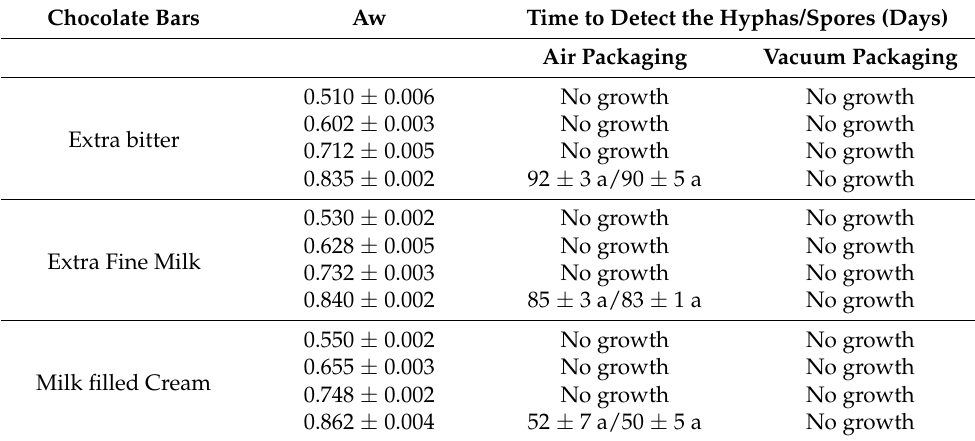
Table 3. Growth of Penicillium lanosocoeruleum in chocolate bars at different Aw levels. Chocolate